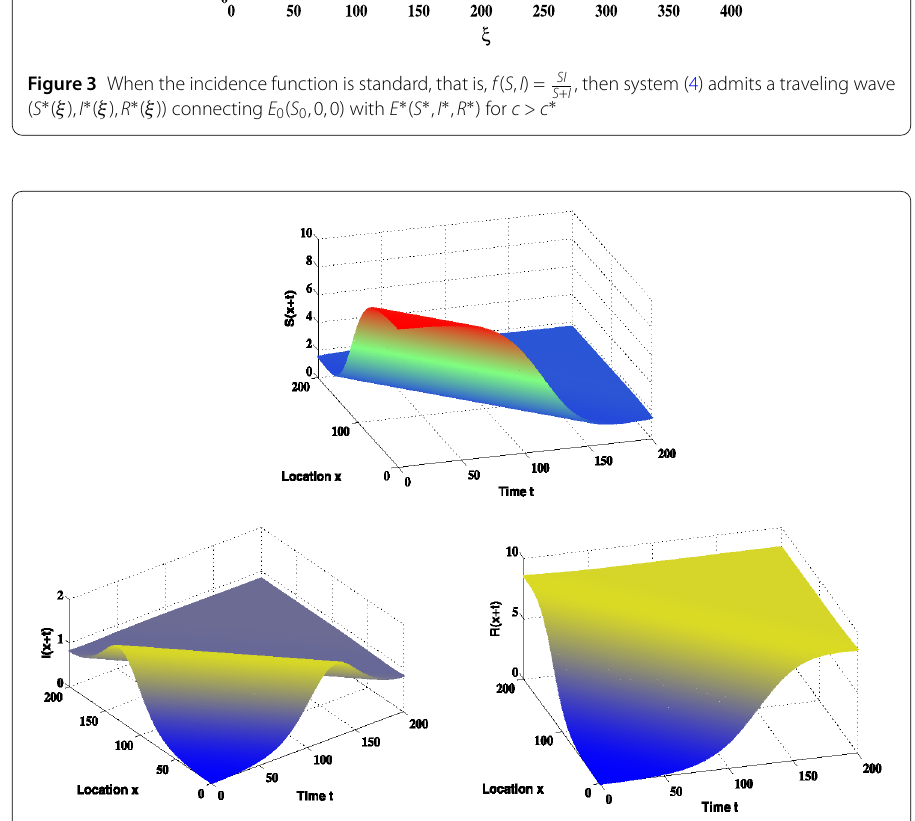
ing wave solution ( S ∗ ( ξ ), I ∗ ( ξ ), R ∗ ( ξ )) connecting E 0 and E ∗ . The dynamical behavior